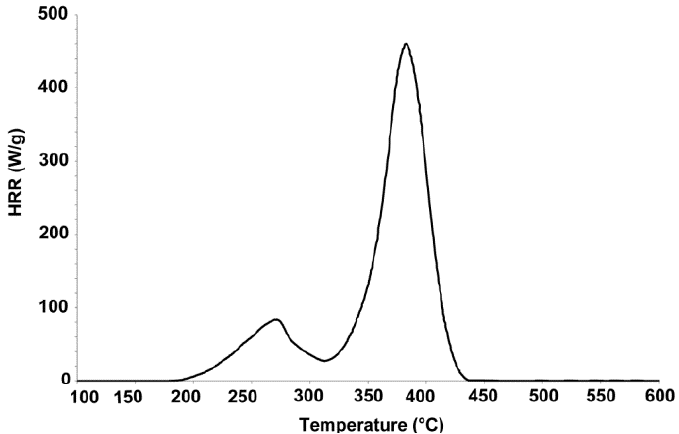
Figure 6. Heat-release rate (HRR) curve of pure FPUF.